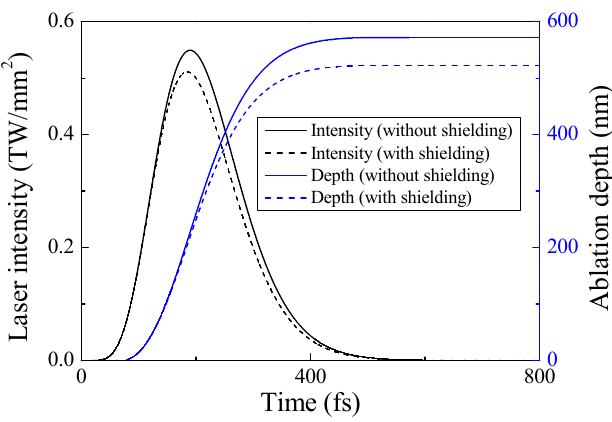
Figure 2. A comparison of laser intensity and ablation depth ( F fluence = 10 J/cm 2 ).